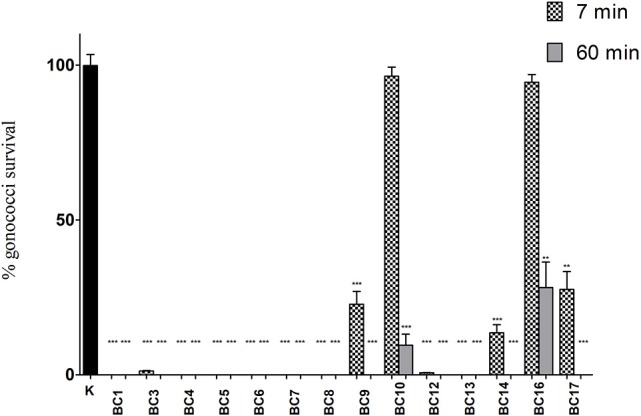
“Inhibition” experiments with lactobacilli CFS. Experiments were performed with a volume of supernatants corresponding to 1 × 108 CFU of lactobacilli added to 1 × 108 gonococcal cells at two different time points: 7 min (dotted bars) and 60 min (gray bars). GC viability was evaluated as number of gonococci/mL and expressed as % of gonococci survival. The results were expressed in percentage compared to control (K) (1 × 108 gonococcal cells incubated in MRS), taken as 100% (black bar). Bars represent mean values, whereas error bars represent SEM. Statistical significance was determined at **P < 0.01 and ***P < 0.0001.